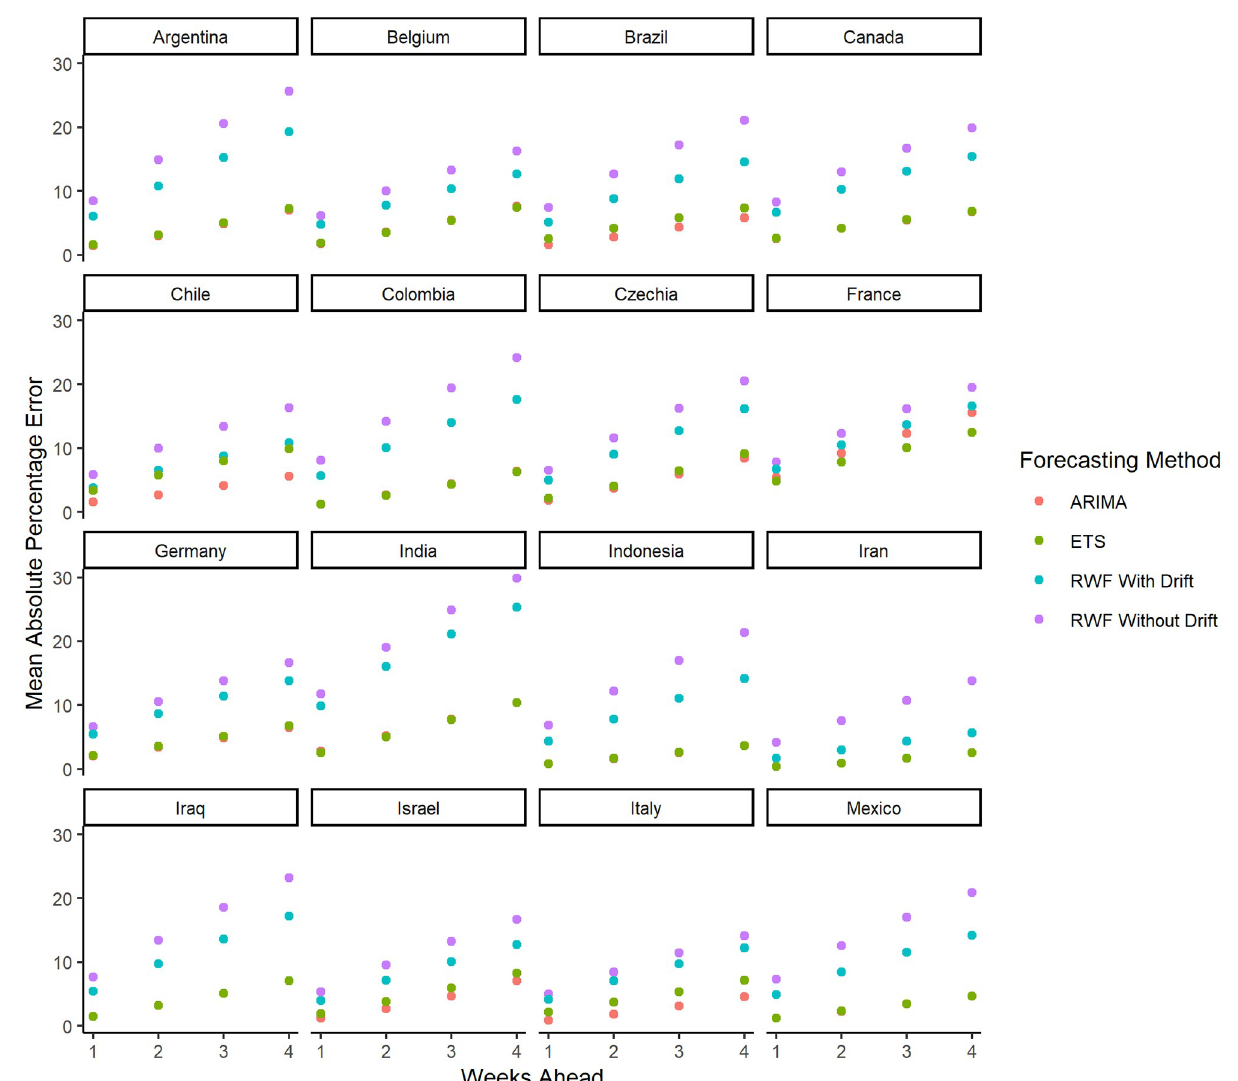
Fig 1. The MAPE for the forecasted values for 16 of the 29 countries with the highest cumulative COVID-19